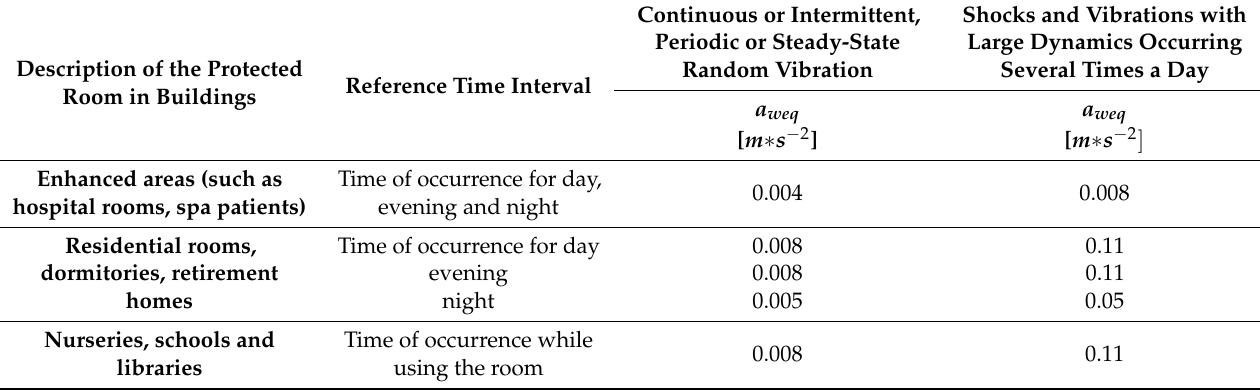
Table 4. Allowed values of vibration quantities in the indoor environment of buildings [58,59].